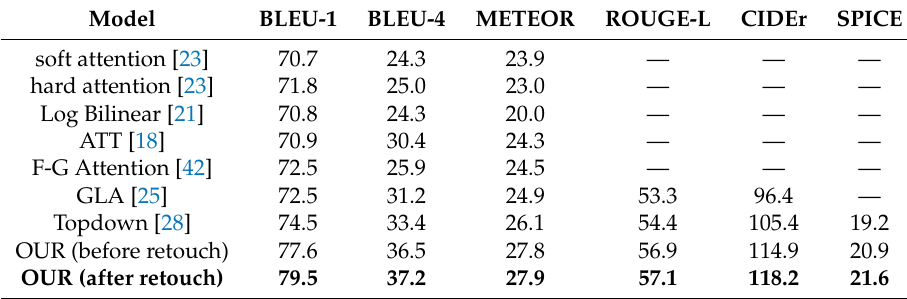
Table 6. Evaluation results of our method on the MS COCO